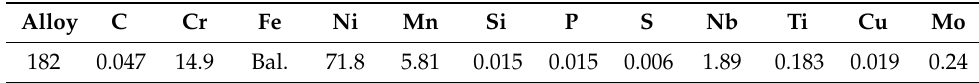
Figure 2. Dissimilar metal weld of Alloy 182 between SA-508 (left) and 316 L (right). Table 1. Chemical composition of the Alloy 182 weld metal.